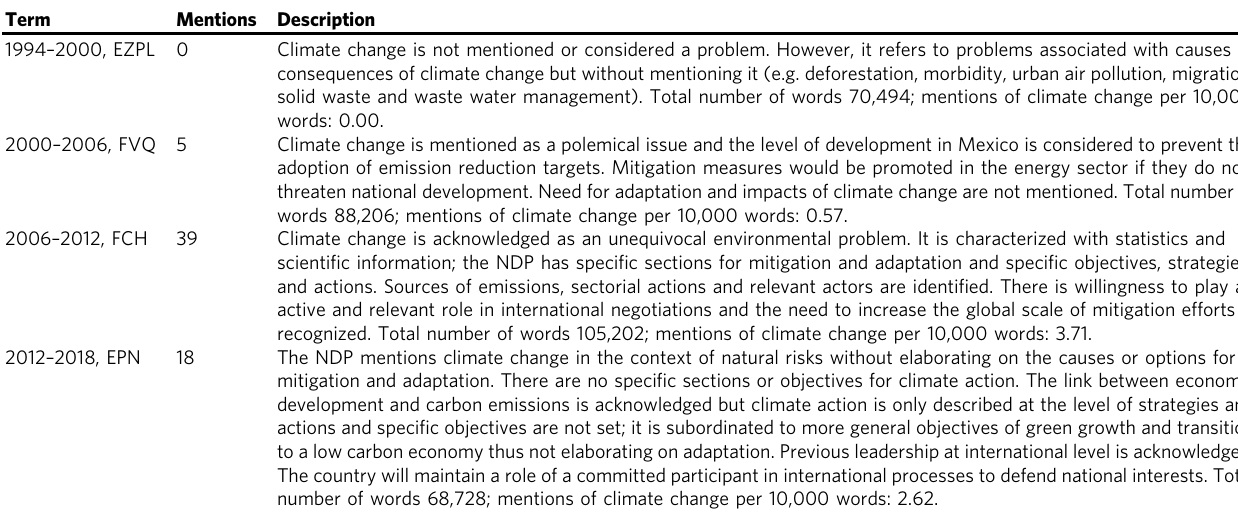
Fig. 2 to examine the change in the trend and not the discrete (i.e. the period from 1998 to 2005 is particularly stable). Figure